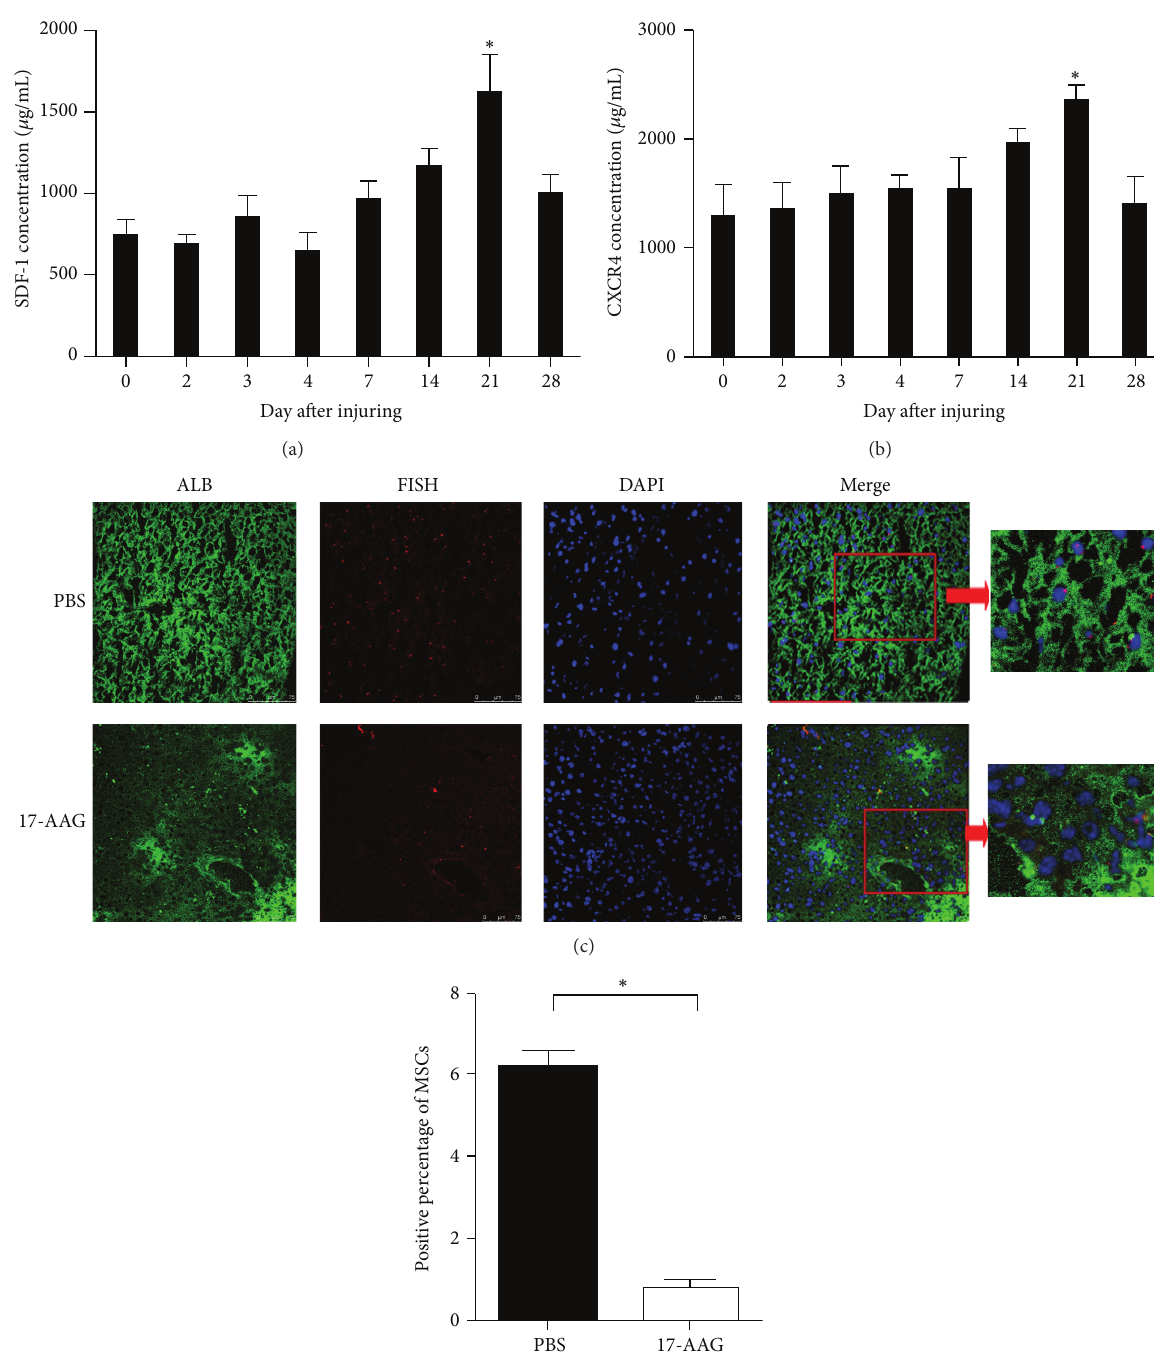
Figure 4: The CXCL12-CXCR4 axis plays an important role in the chemotaxis of MSCs. (a-b) ELISA was used to detect SDF-1 and CXCR4 protein levels in the damaged liver tissue at different times after injury. The data are the mean ± SEM from three independent experiments ( ∗ 𝑃 < 0.05 compared with day 0). (c-d) 1 × 10 6 MSCs were preincubated with 17-AAG (SDF-1 inhibitor, 20ng/mL) or PBS for 30 min and injected into the tail veins of bone marrow-destroyed female C57BL/6 mice. Then, liver damage was induced in the mice, and tissue sections were collected 21 days after injury. (c) IF was used to detect ALB-positive cells, and FISH was used to identify the Y chromosome-positive cells. Bar: 75 𝜇 m. Arrow was directed to the double positive cells. (d) Both ALB- and FISH-positive cells were counted. All the experiments were repeated three times, at least 3 samples were included in each